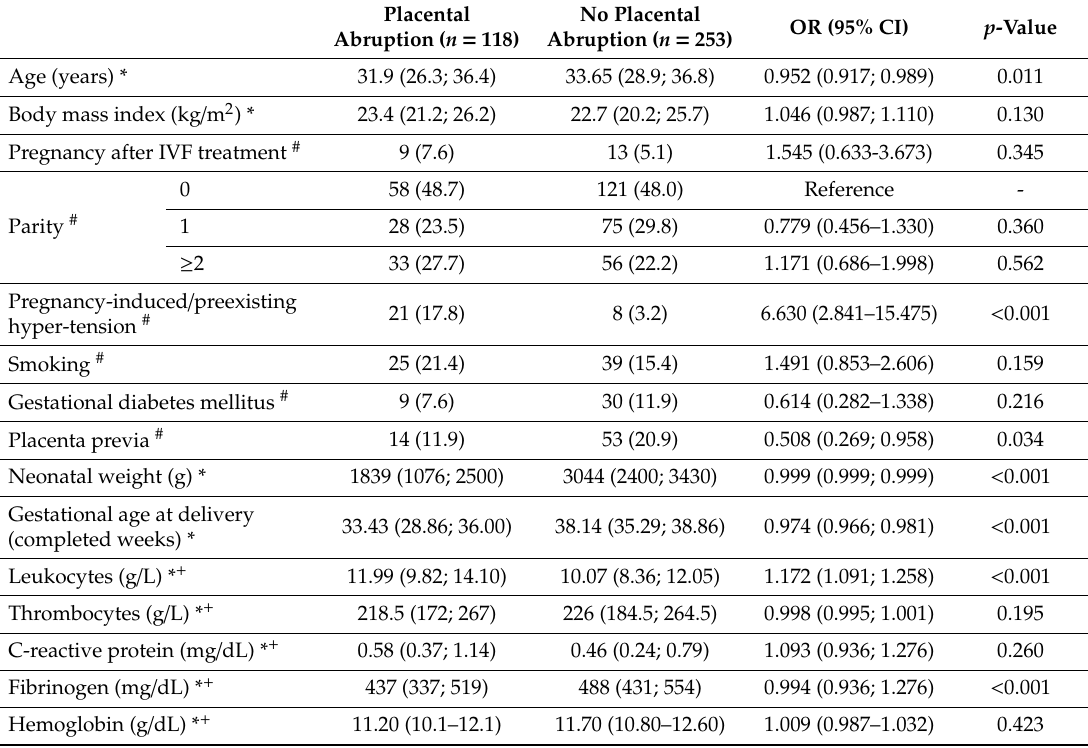
Table 1. Women with and without placental abruption: comparison of basic patient characteristics and laboratory parameters within 48 h before delivery between all cases and all